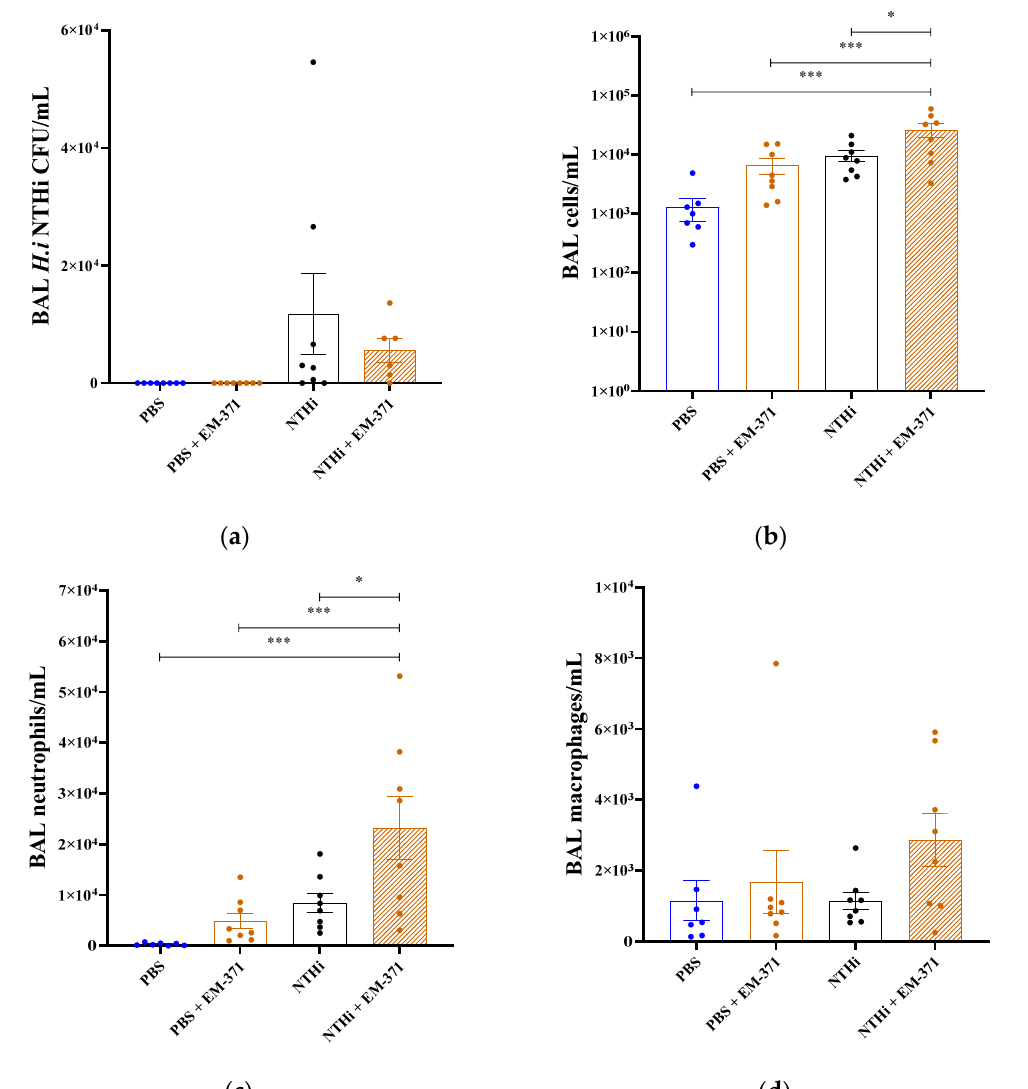
Figure 3. Infiltrating cells and viable NTHi recovered in BAL 48 h post infection. ( a ) BAL were diluted and plated on BHi agar supplemented with hemin and NAD. Colonies were enumerated after 48 h incubation at 37 °C. ( b ) BAL cells were enumerated using Malassez slides, cytocentrifuged and stained with May–Grünwald–Giemsa. The ( c ) neutrophils and ( d ) macrophages were enumerated and expressed as the number of cells/mL of BAL. One-way ANOVA using Tukey’s multiple comparisons test was performed with GraphPad version 8 to determine the statistical significance. p -values: *: p < 0.03, ***: p <